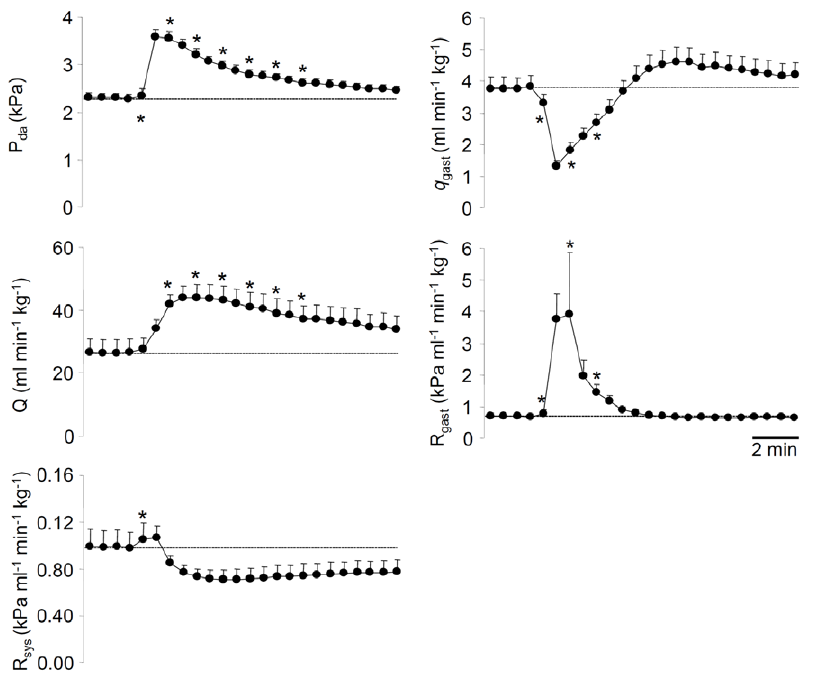
Figure 4. Cardiovascular responses to adrenaline. Adrenaline (5 nmol kg 2 1 ) was injected into unfed P. borchgrevinki (N=7–12). The variables are dorsal aortic blood pressure (P da ), cardiac output (Q), systemic vascular resistance (R sys ), gastrointestinal blood flow (q gast ) and gastrointestinal vascular resistance (R gast ). Dotted vertical lines extrapolate baseline values for visual aid. Values are means ( + S.E.M.) and * denotes significantly different value (p , 0.05) from the pre-injection control period.